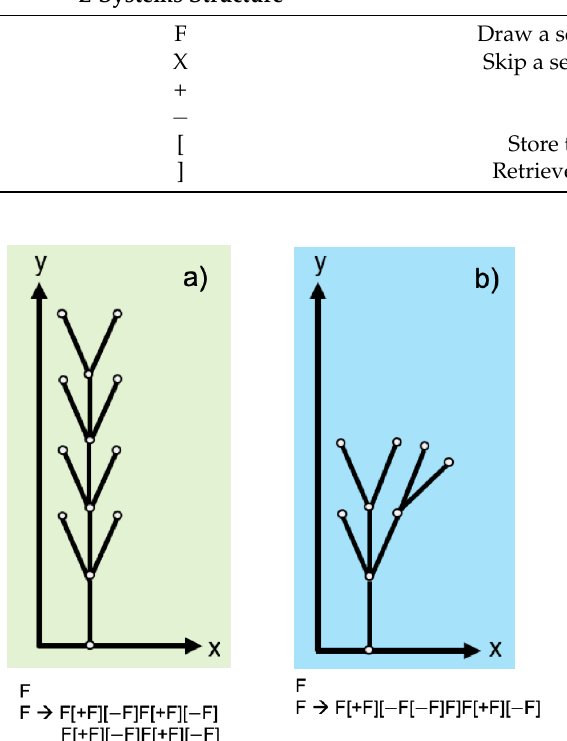
Table 1. L-systems ’ structure and related turtle commands.